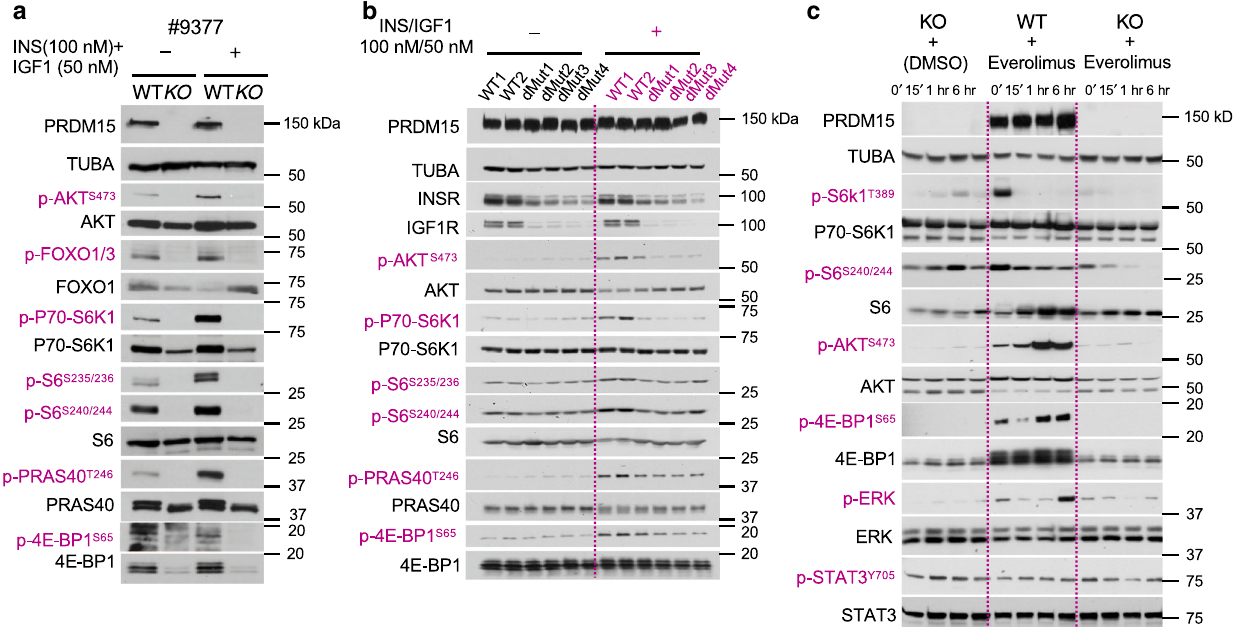
Fig. 5 PRDM15 is critical for PI3K/AKT/mTOR activity in E µ -Myc B-cell lymphomas. a Western Blot analysis of key signaling axes of the PI3K/AKT/ mTOR pathway in starved Prdm15 F/F vs. Prdm15 Δ / Δ E µ -Myc B-cell lymphomas, 15 ’ following stimulation with INSULIN/IGF1. b Assessment of PI3K/AKT/ mTOR pathway activity, as in a , in wild type vs. Insr BSKO / Igf1r KO double mutant E µ -Myc B-cell lymphoma clones. c Time course analysis, by WB, of key components of the PI3K/AKT/mTOR to monitor the compensatory phosphorylation/activation of alternative signaling cascades in E µ -Myc lymphoma cells treated with everolimus (mTORC1-i) or/and depleted of PRDM15; Prdm15 Δ / Δ cells fail to rewire their signaling. p-STAT3 levels were used as a negative control to show that PRDM15-mediated effects are speci fi c to the PI3K/AKT/mTOR pathway. Data in a ( n = 3 independent primary lines) and c ( n = 2 independent primary lines) are from a representative experiment. Data in b are from independent clones (two WT and four